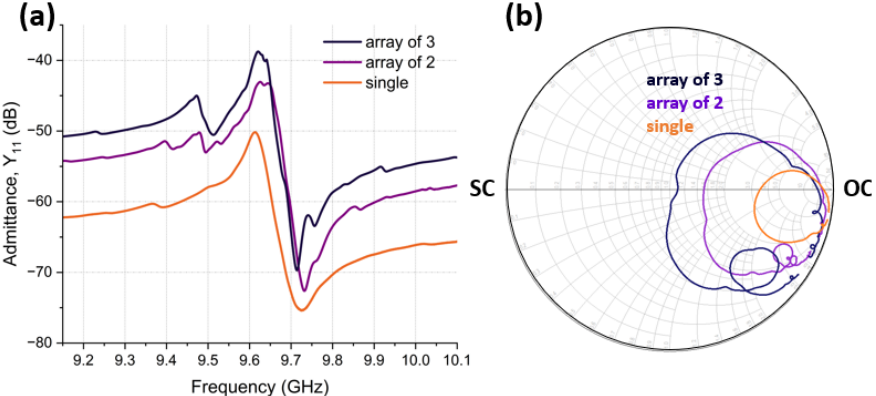
Figure 9. Impedance scaling: ( a ) Admittance response of a single CLMR, array of 2 CLMRs, and array of 3 CLMRs. ( b ) Impedance scaling shown on the Smith